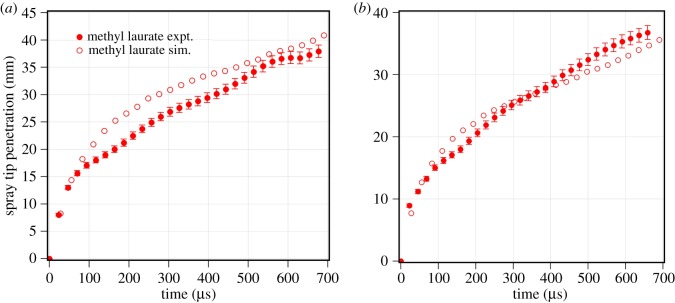
Comparison of measured and predicted spray tip penetration of methyl laurate. (a) Pinj=1500 bar and Pamb=30 bar. (b) Pinj= 1500 bar and Pamb=40 bar.